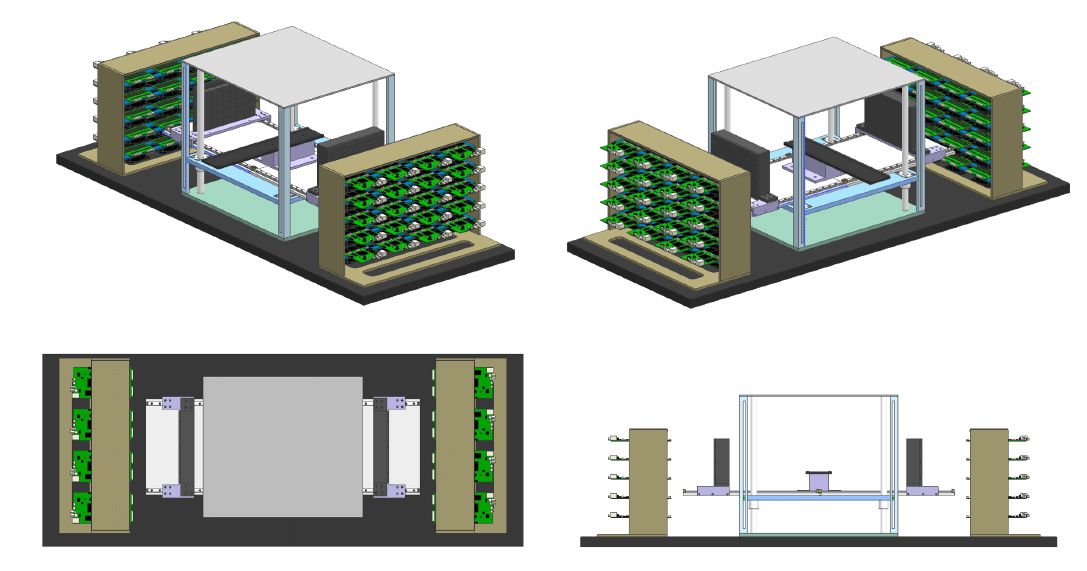
Figure 4. Different views of the design of the prototype of P&I PET monitoring system for proton beam therapy. The detector modules (flat black panels), the electronic board housing (side structures)